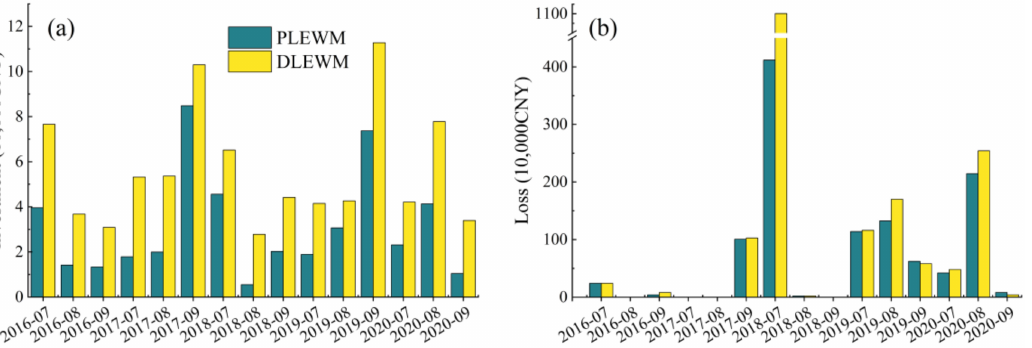
Figure 18. Expected investment for issuing early warning information and losses caused by landslides which were calculated by the criteria in Table 1. The units are in China Yuan: ( a ) Investment, ( b )